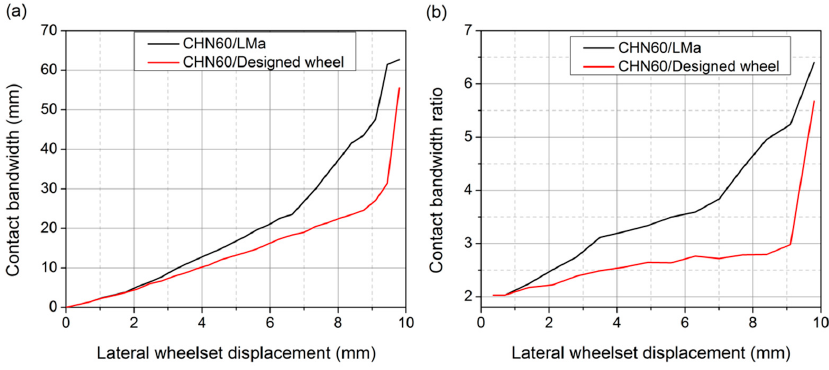
Figure 18. Contact bandwidth and contact bandwidth ratio. ( a ) Contact bandwidth; ( b ) Contact bandwidth ratio.